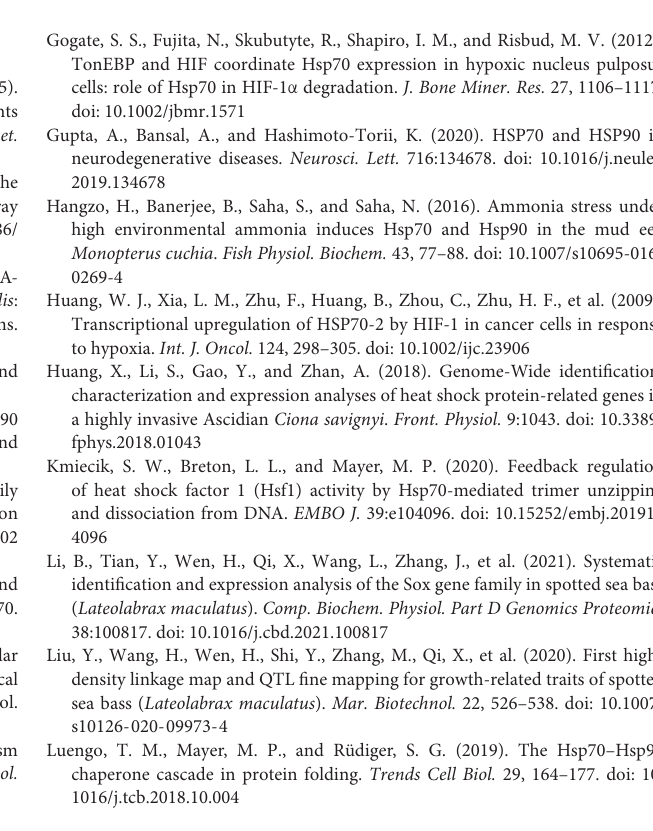
Supplementary Figure 1 | Schematic diagram of heat stress experiment. Spotted seabass individuals were acclimated for 48 h at ambient temperature (25 o C) before heat stress treatment. Water temperature was elevated at a constant rate of 1 o C/h until 32 ◦ C. Fish individuals were sampled at four time points including 0 h (H0), 10 h (3 h after heat stress, H3), 19 h (12 h after heat stress, H12) and 31 h (24 h after heat stress, H24), respectively. Supplementary Figure 2 | Predicted protein-protein interaction network of HSF1 and HSPs in spotted seabass. This network was predicted by the online STRING database. The balls represented the gene nodes, and the connecting lines and arrowheads indicated the interactions. HSP, heat shock proteins; HSF, heat shock